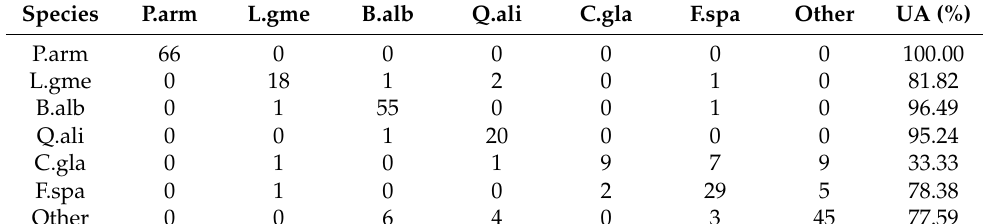
Table 12. Classification confusion matrix of tree species at altitude of 2000 m based on XGBoost.